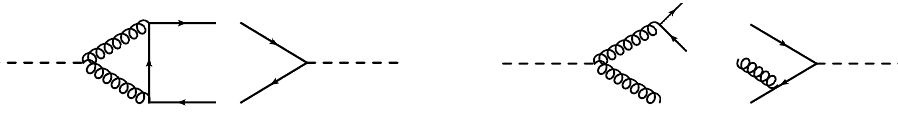
Figure 1. Representative Feynman diagrams for the “LO” contributions to the processes discussed in this paper, there are two separate processes corresponding to two-body, and three-body decays of the Higgs. Both processes occur through an interference of a traditional y b amplitude, with an EFT induced